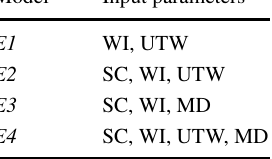
Table 3 Input scenarios